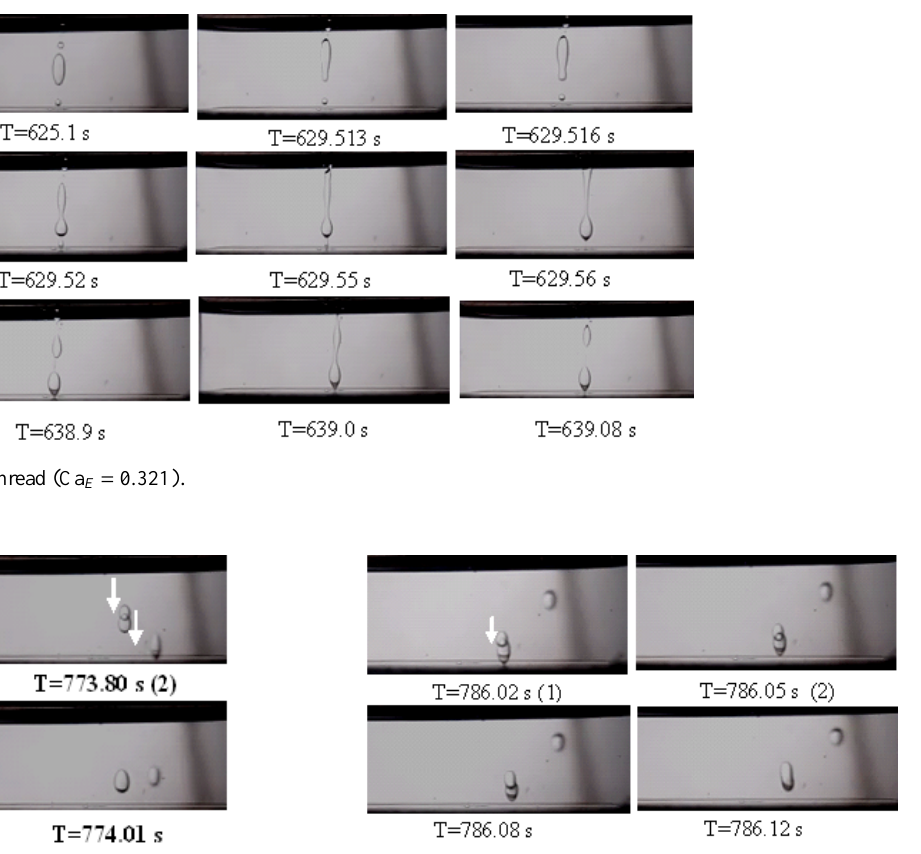
Figure 13. The first type of droplet coalescence (Ca E = 0 . 360). Fig 13. The first type of droplet coalescence (Ca